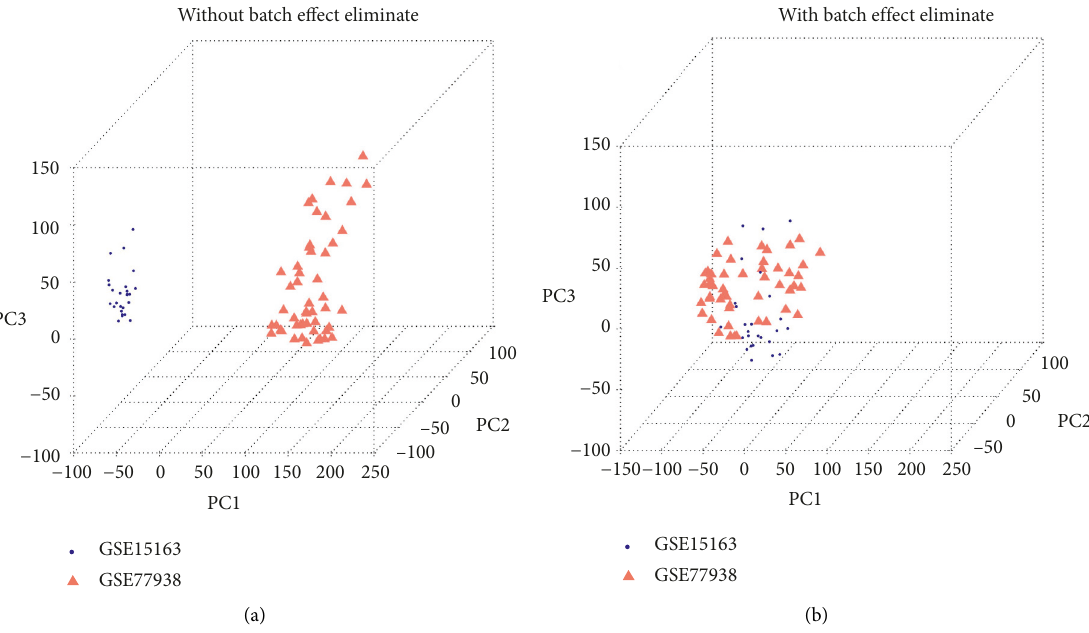
Figure 1: (a) Without batch effect eliminate. (b) With batch effect eliminate.